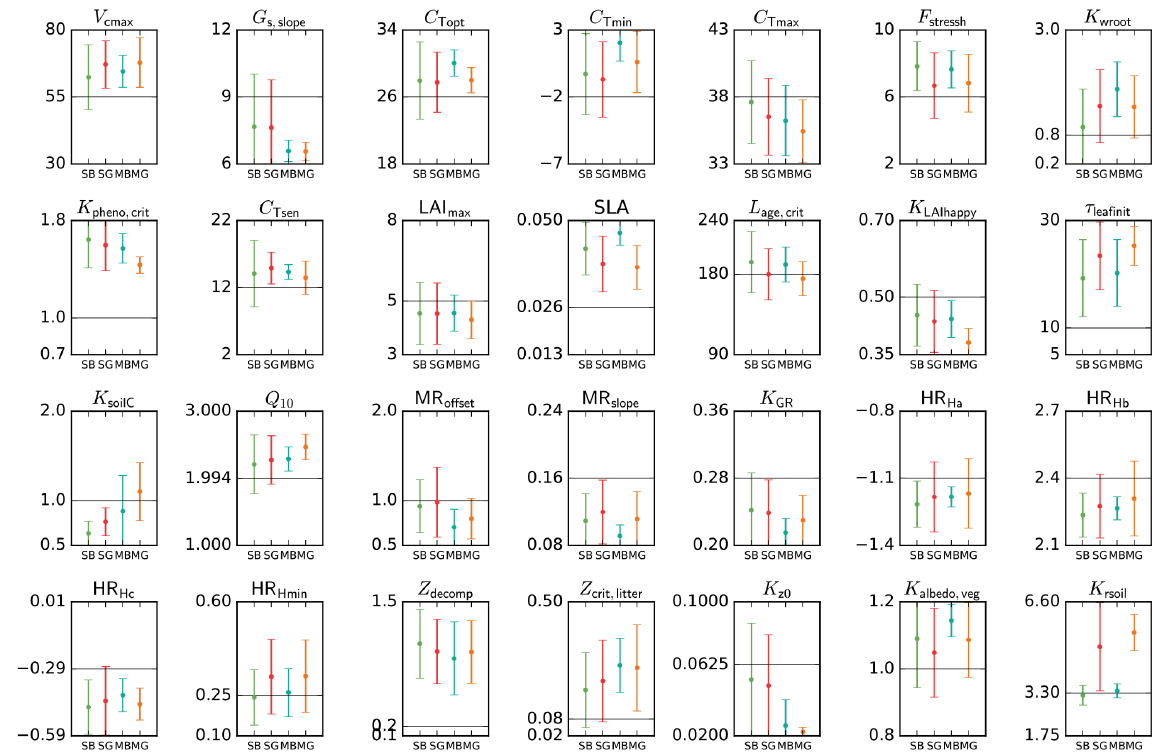
Figure 5. Mean posterior model parameter values for temperate deciduous broadleaf forest PFT. Results for the four different methods ( S BFGS , SB; S Genetic , SG; M BFGS , MB; and M Genetic , MG) are displayed: mean value and standard deviation across 16 random first-guess tests. Grey horizontal lines represent prior values, which are equal to the default ORCHIDEE model values. The vertical axis limits represent the range of parameter